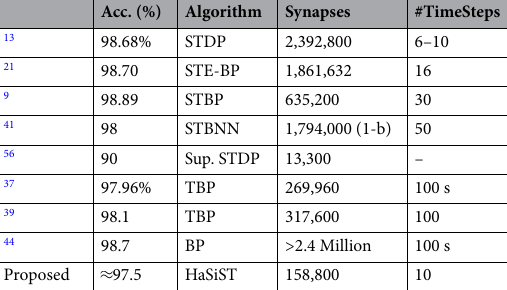
Table 2. Accuracy Comparisons -